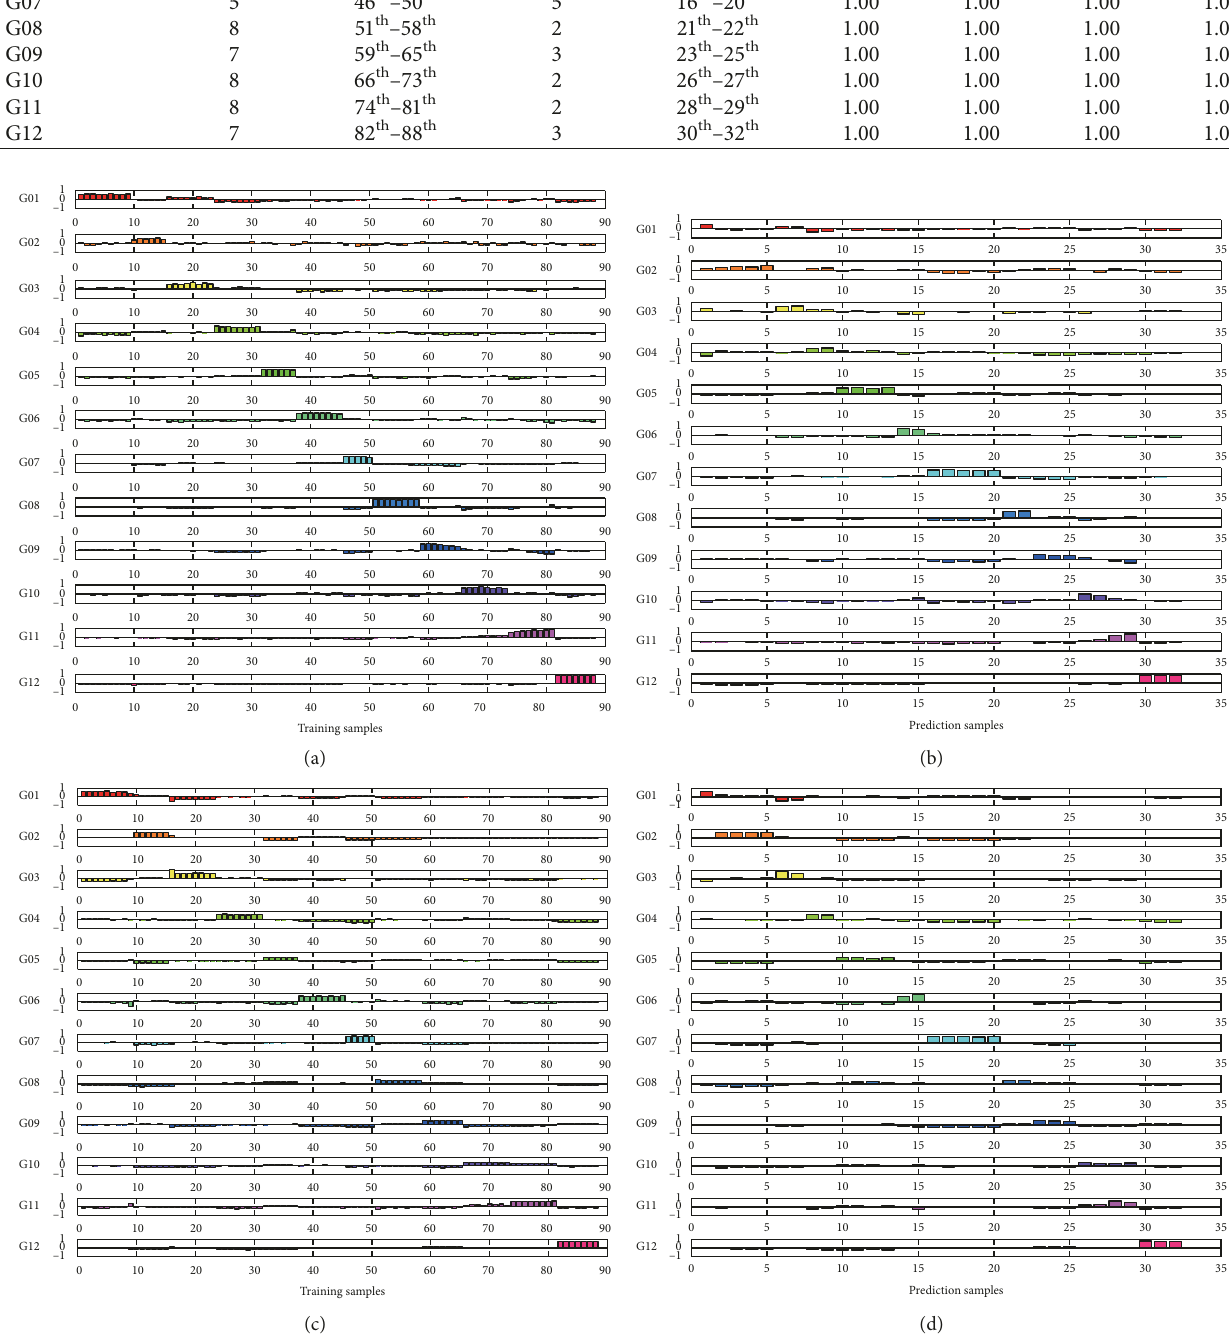
Figure 2: Dummy vectors (G01, G02, G03, G04, G05, G06, G07, G08, G09, G10, G11, G12) of PLSDA for 12 famous green tea samples with different species and grades: (a) 88 training samples from MIR PLSDA model; (b) 32 prediction samples from MIR PLSDA model; (c) 88 training samples from NIR PLSDA model; (d) 32 prediction samples from NIR PLSDA